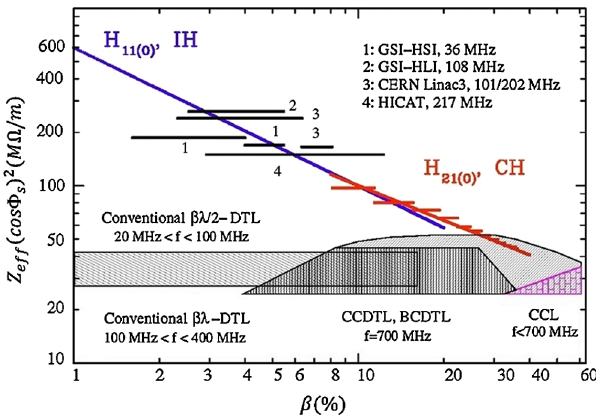
FIG. 20. Effective shunt impedance for different rf structures including the transit time factor T and the synchronous phase ’ as a function of the particle velocity (cid:1) ¼ v=c . The black horizontal bars represent some realized interdigital H -mode (IH)-DTL’s while the blue line represents the expected shunt impedance from IH cavities. The red line represents the expected shunt impedance of the room temperature CH cavities for the GSI-FAIR 70 MeV, 70 mA proton linac [26].